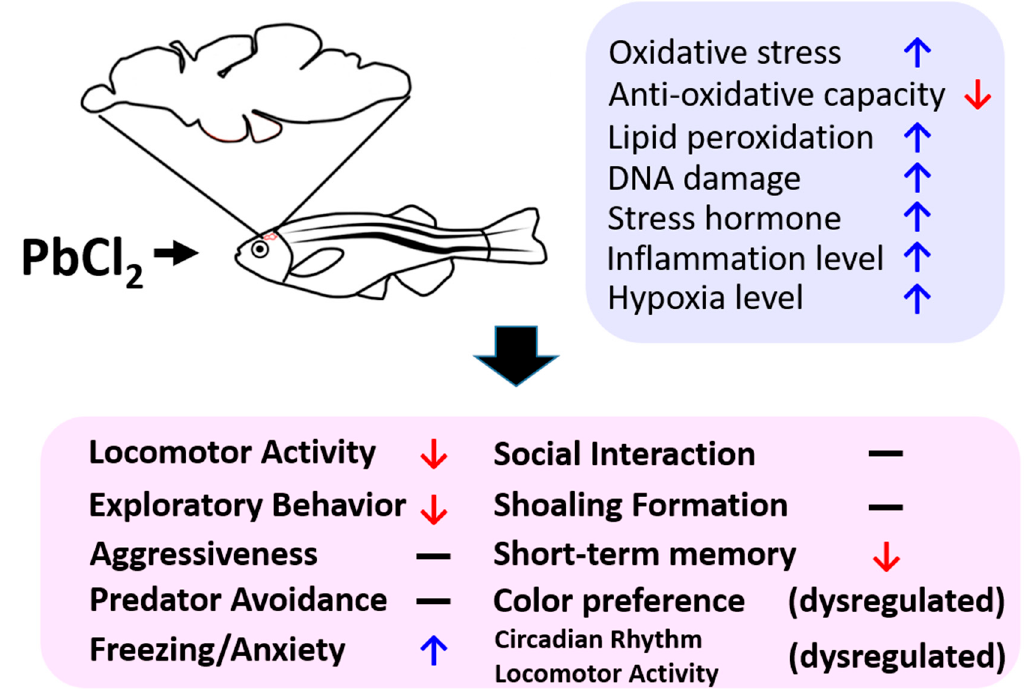
Figure 10. Schematic representation of the biochemical and behavioral signatures detected in chronic and low dose PbCl 2 -exposed zebrafish. The signatures of biochemical (blue) and behavioral (pink) tests are summarized ( ↑ : upregulated, ↓ : down regulated).